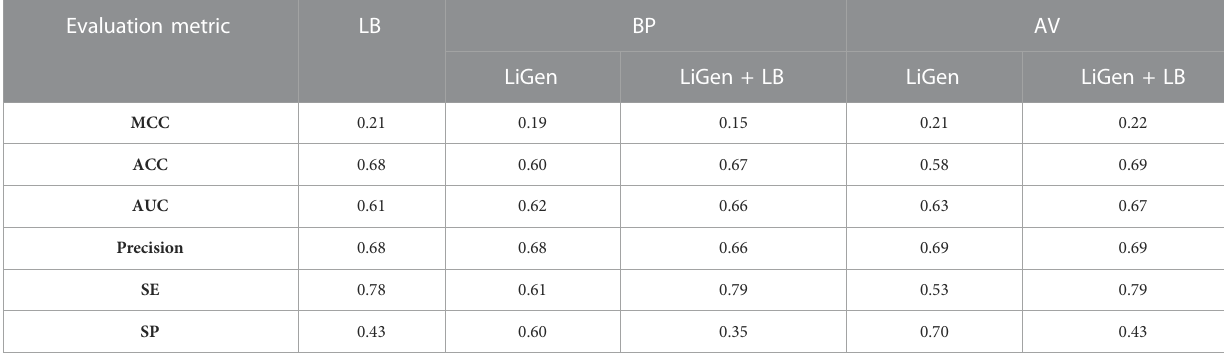
TABLE 4 Evaluation of the performances of the classi fi ers on the external test set. Evaluation